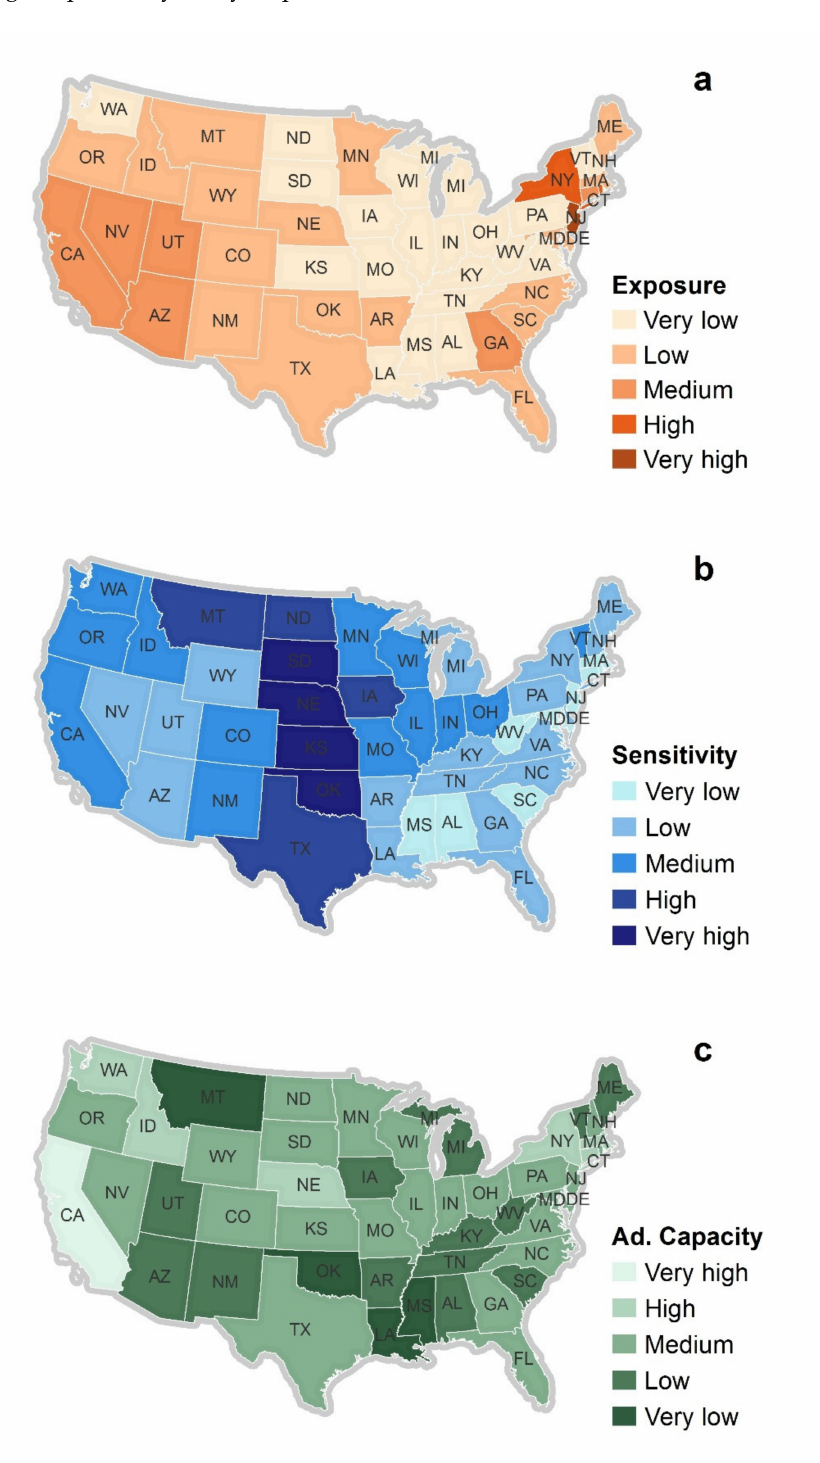
Figure 3. Maps giving an overview of the relative ( a ) exposure, ( b ) sensitivity, and ( c ) adaptive capacity of the contiguous U.S. states. It is noted that only one state (New Jersey) is in the “Very high” Exposure